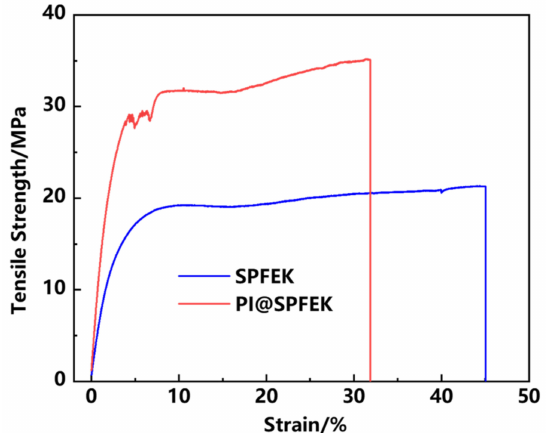
Figure 5. Tensile stress–strain curves of SPFEK and PI@SPFEK in a hydrated